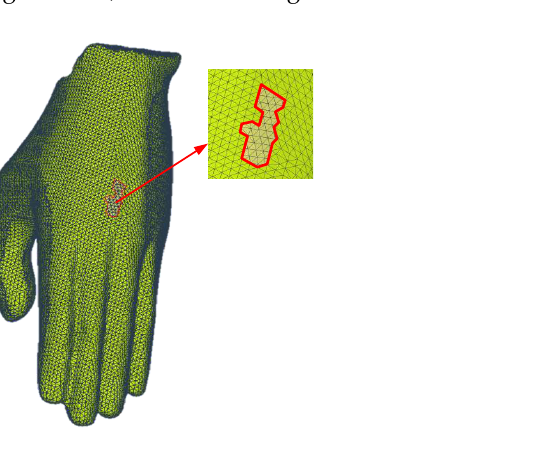
Figure 4. The up module and down module in the generator of MU-GAN. more realistic with the target distribution. Based on the network proposed in [35], the global features are obtained through a set of fully connected and max-pooling layers. To im- prove feature integration, a self-attention module is utilized after feature concatenation. Finally, the confidence value is generated by applying a set of MLPs, the max-pooling layer, and the fully connected layer to determine whether the input data are close to the true distribution.